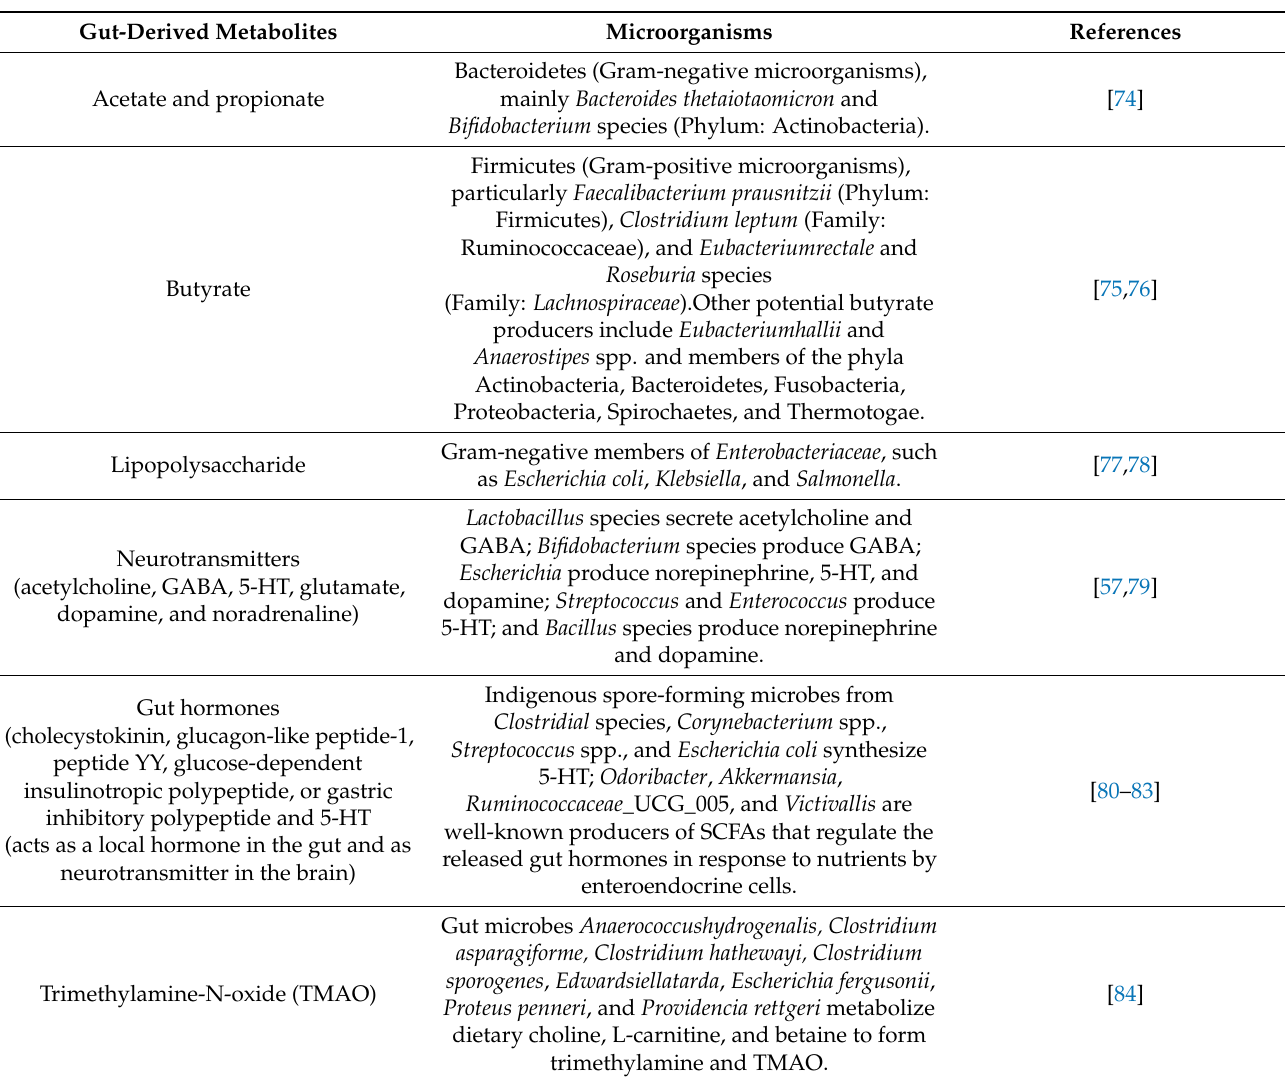
Table 1. Gut-derived bioactive metabolites and associated